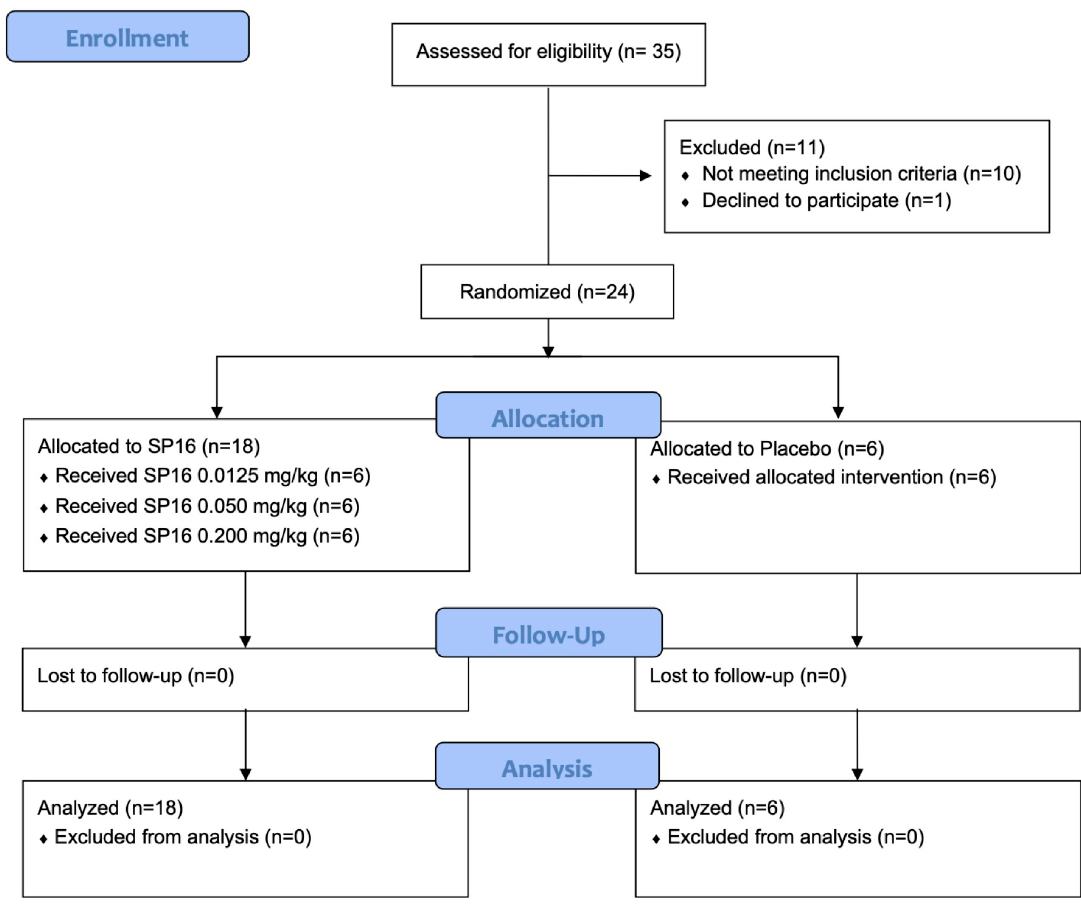
Fig 3. CONSORT participant flow diagram.